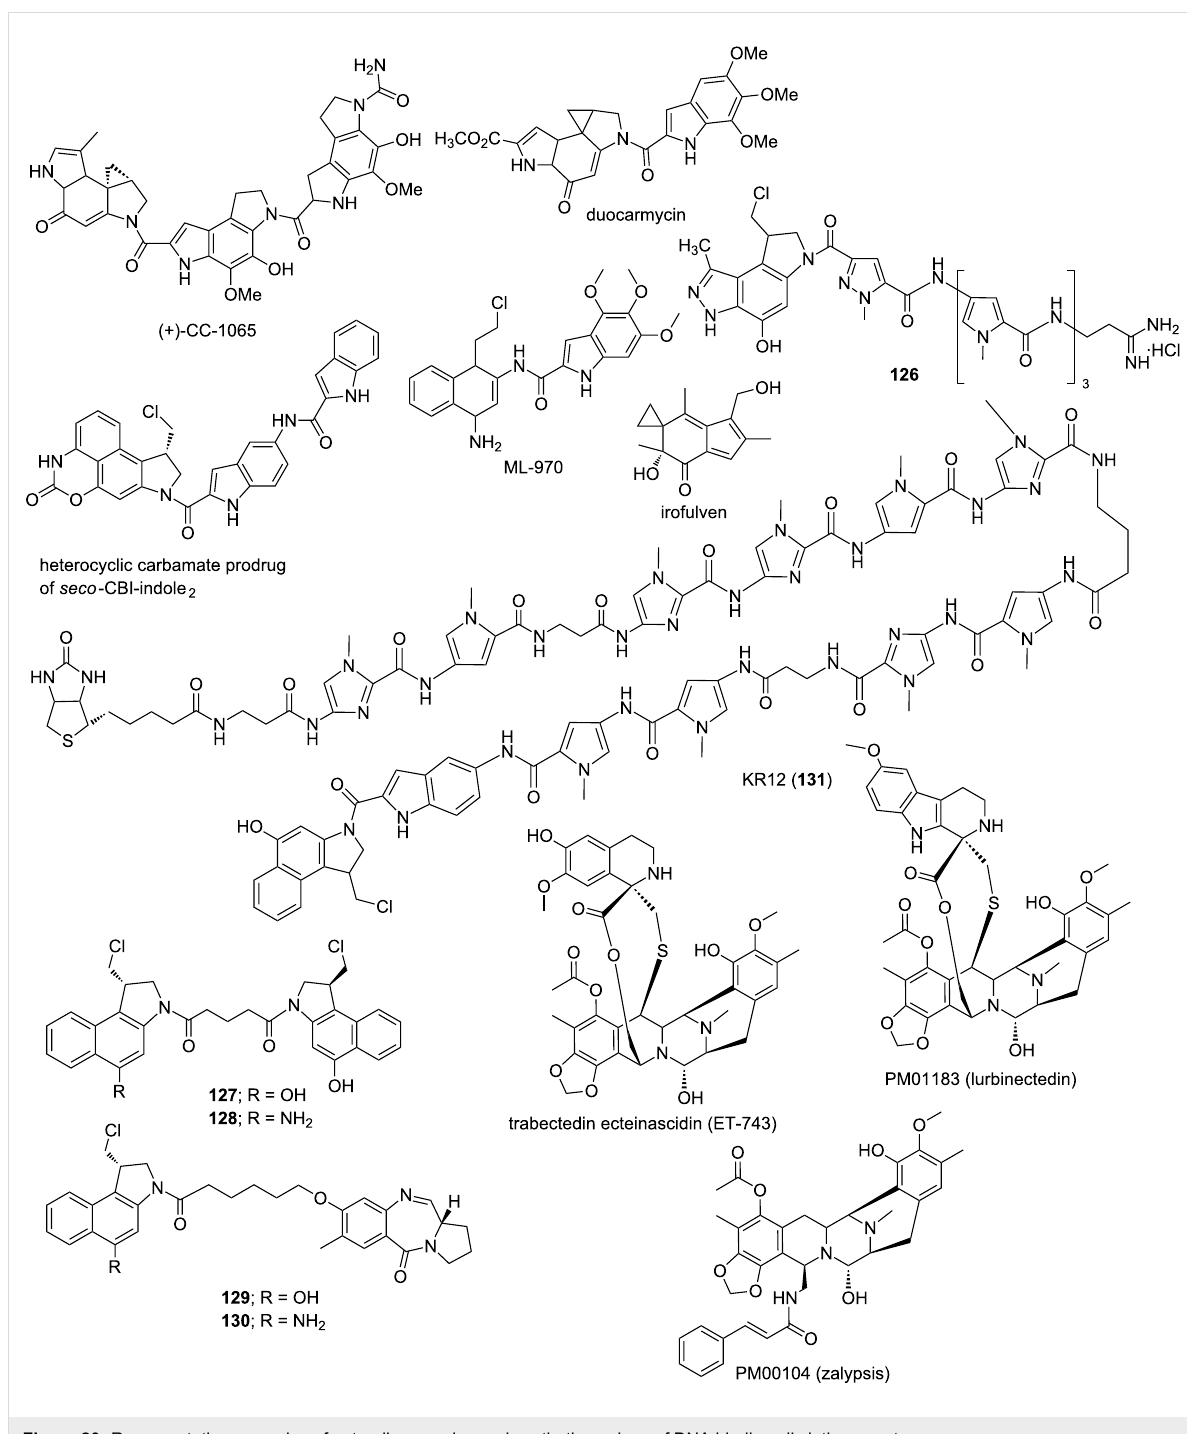
Figure 20: Representative examples of naturally occurring and synthetic analogs of DNA binding alkylating agents.